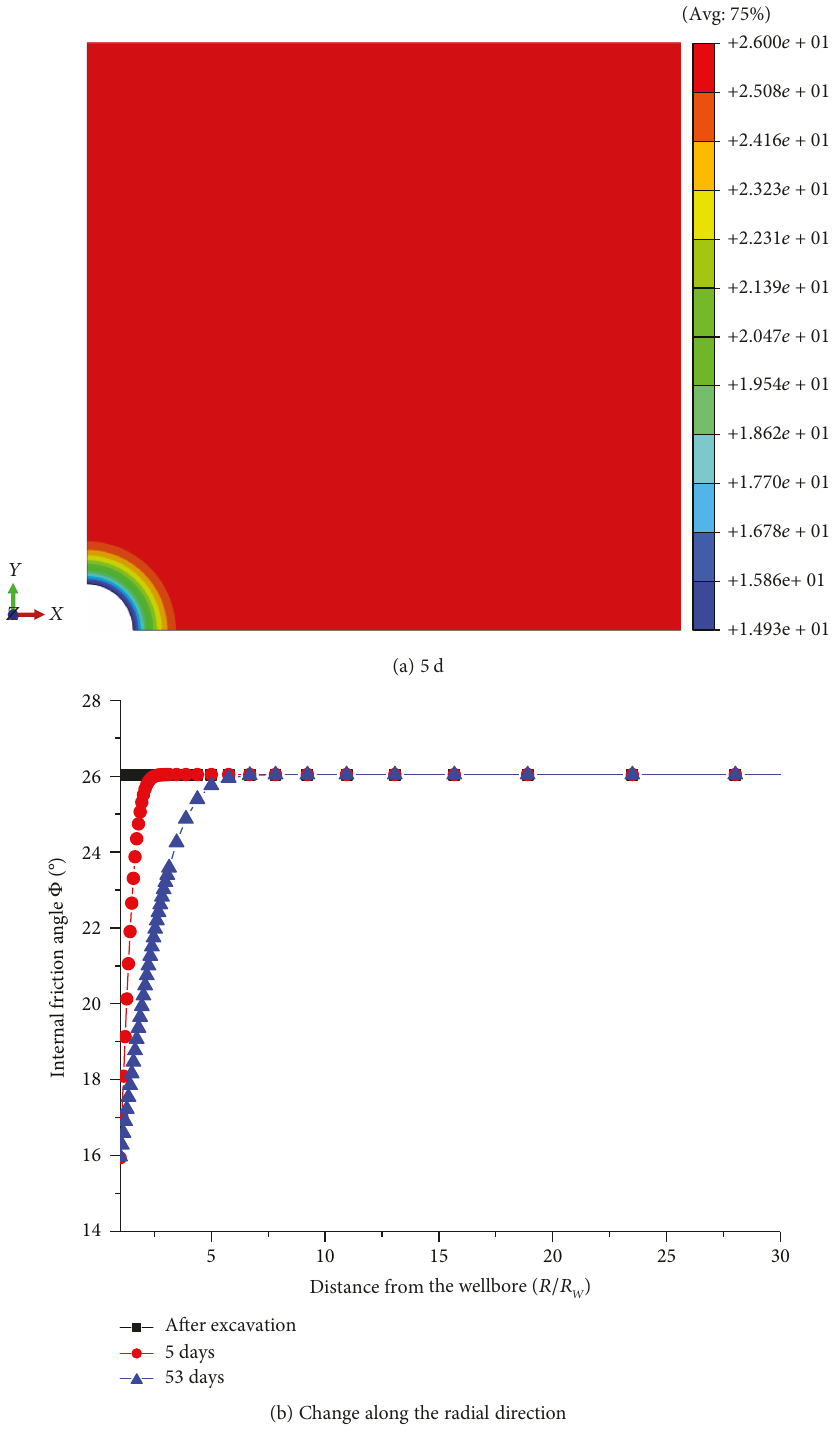
Figure 13: Variation of the friction angle of the formation after